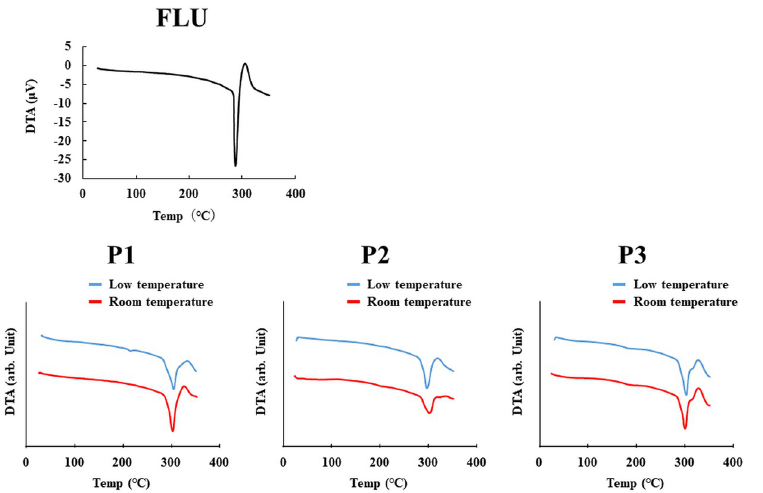
Fig 3. Changes in the melting points of each formulation of 0.1% FLU ophthalmic suspensions. In low (blue line) and room (red line) temperature groups, each formulation of 0.1% FLU ophthalmic suspension was stored at 10 ˚C for three months and subsequently maintained at room temperature for two months or left at room temperature for five months. The melting point of each formulation was measured on a simultaneous thermogravimetric analyzer. P1; Original, P2; Generic A, P3; Generic B, DTA; Differential thermal analysis.